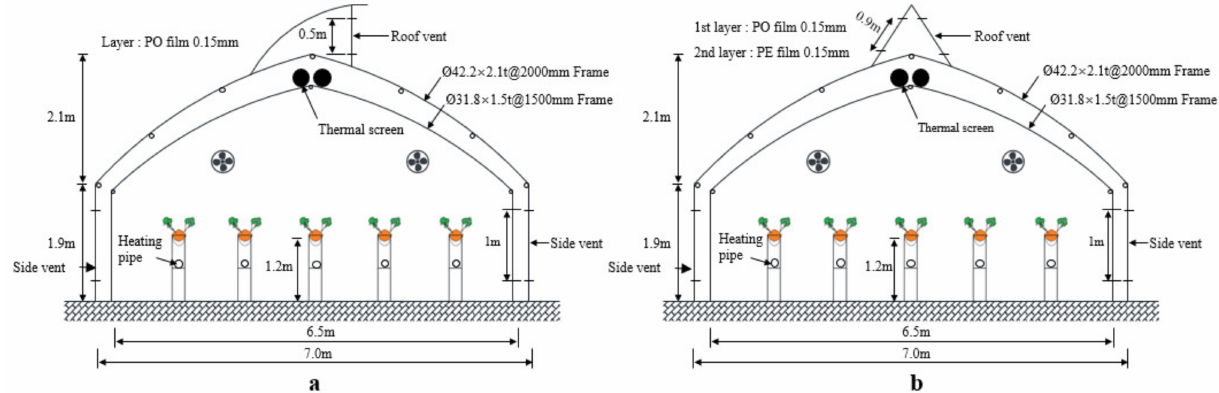
Figure 1. Single-span gothic-type experimental greenhouse. ( a ) SLG ( b ) DLG.